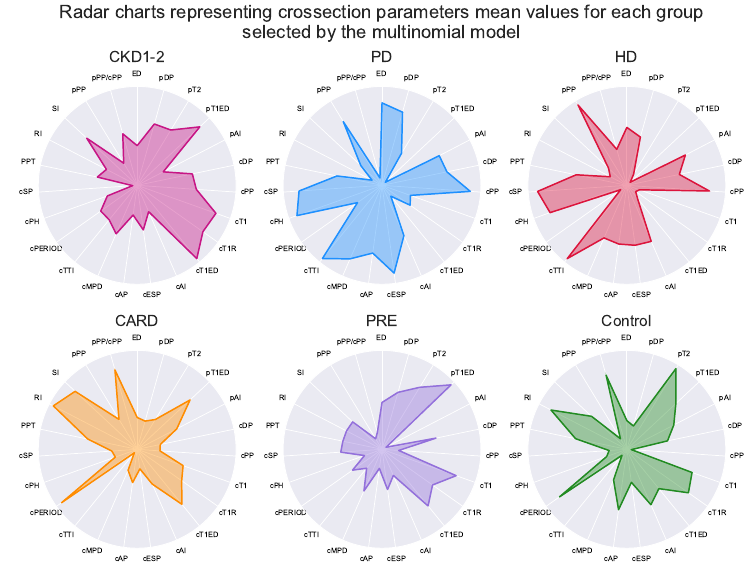
Figure 6. Original tonometric mean parameters values. The values for each individual parameter were standardized according to the scalar created for the whole patient population (n = 252) and normalized to fall between 0 and 1 values afterward. The radar plots consist of 39 tonometry parameters and show where the means inside every group lie (after scaling). The lowest values are in the circle center, and the highest touch the circumference. The white lines are provided to easily track values calculated for each parameter according to the label outside the circle.